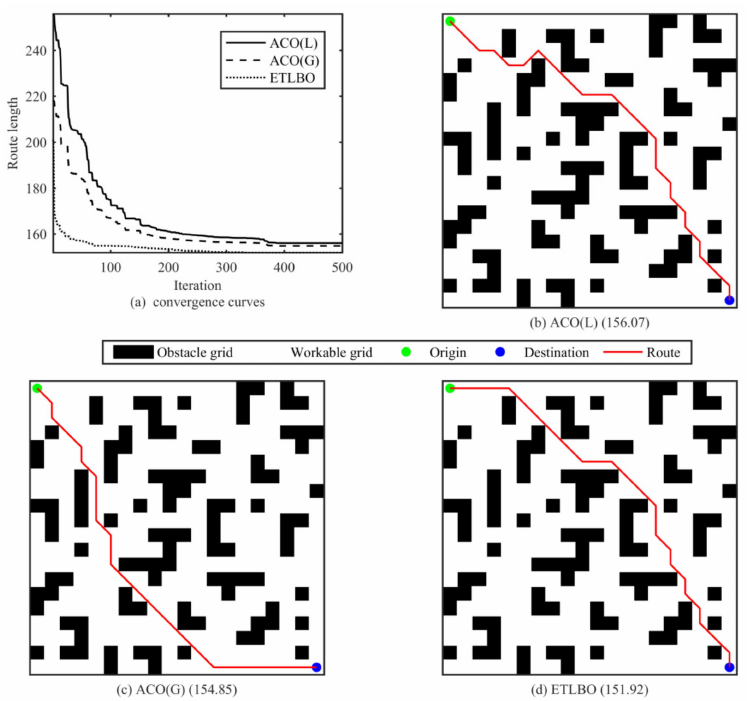
Figure 6. Best solution information of instance 20 ×